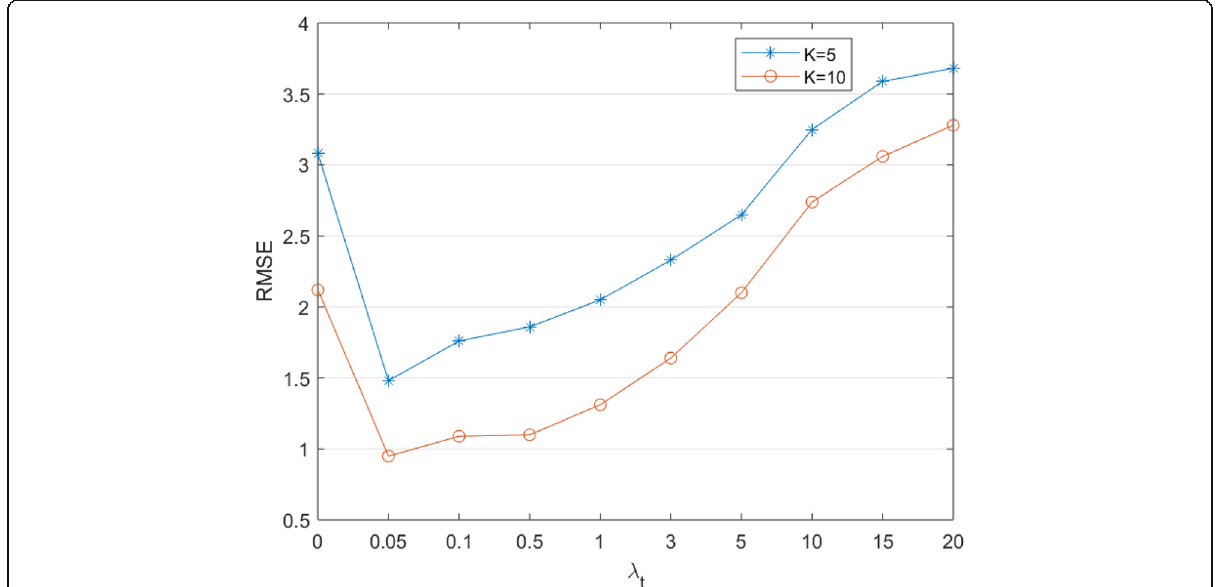
Fig. 5 RMSE vs. λ t on Ciao. The blue line with K = 5, and the green line with K = 10